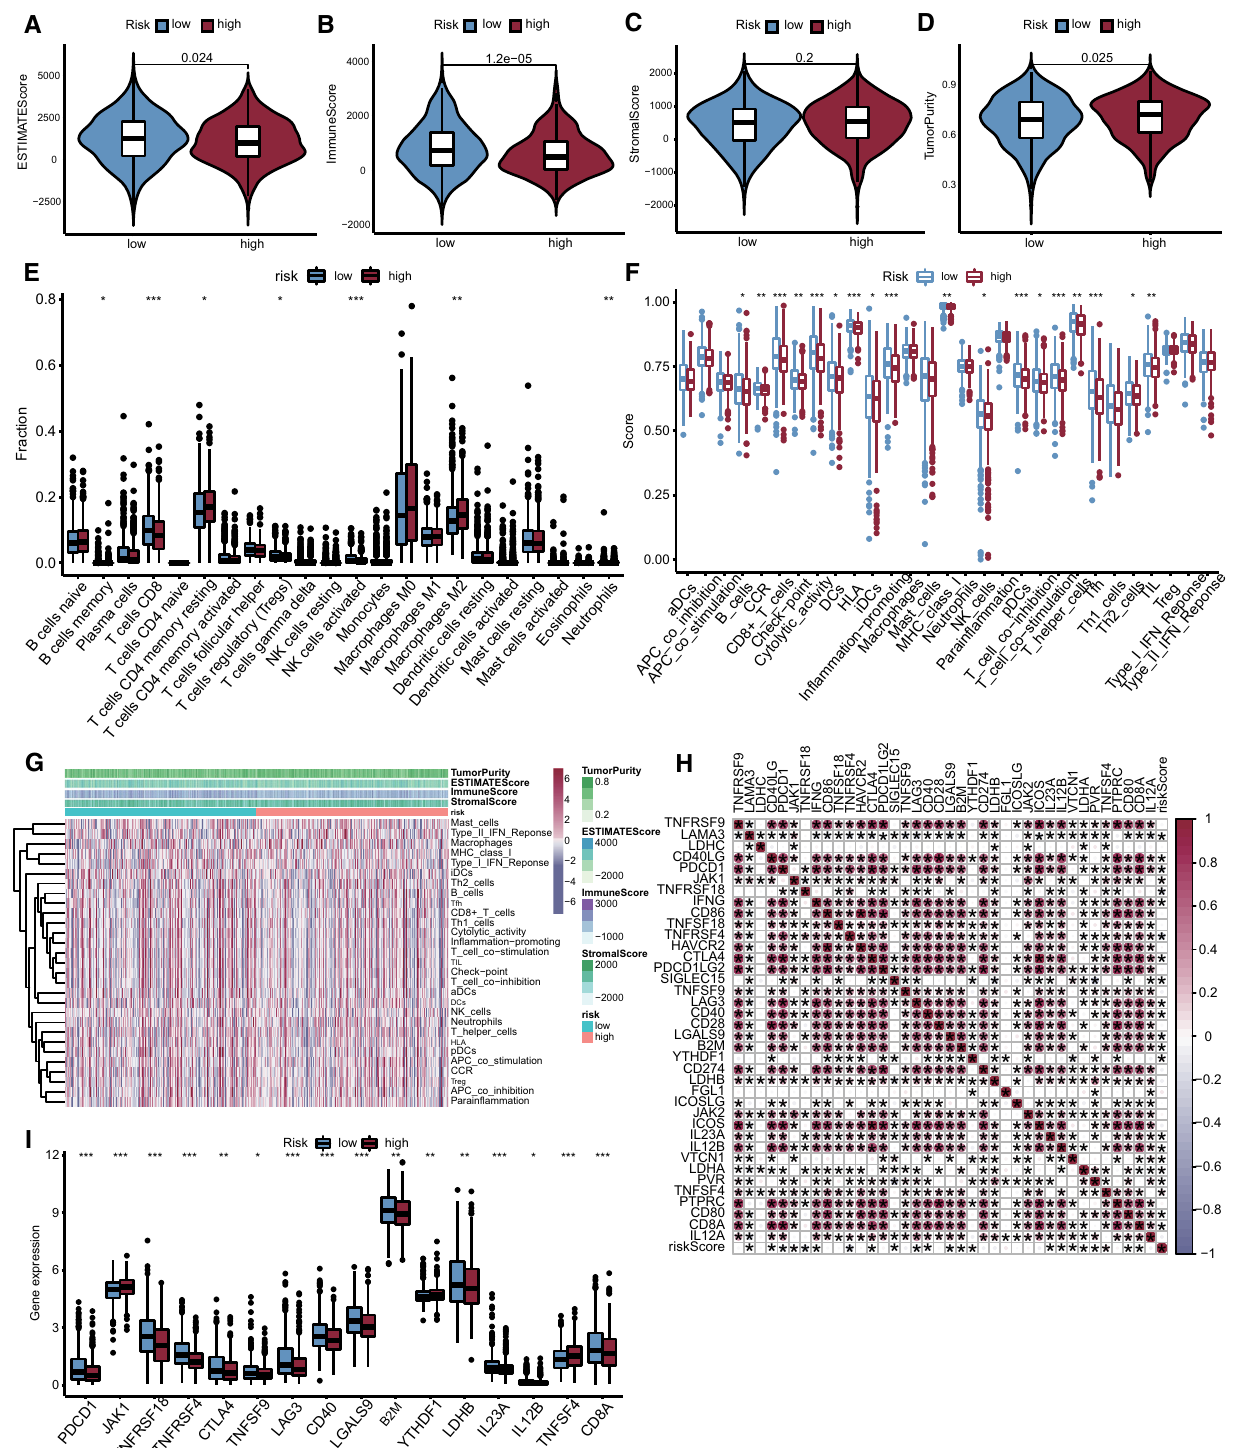
Fig. 4 Analysis of the tumor microenvironment and immune infiltration. A – D Violin plots of ESTIMATE score, immune score, stromal score, tumor purity differences between high- and low-risk groups; E Box plot of CIBERSORT results; F Box plot of ssGSEA results; G Heatmap of comprehensive results of ESTIMATE results and ssGSEA results; H Correlation scatter plot of 38 immune checkpoint differences between high- and low-risk groups; I Box plot of significantly different immune checkpoints between high- and low-risk groups. (*p < 0.05, **p < 0.01, ***p <